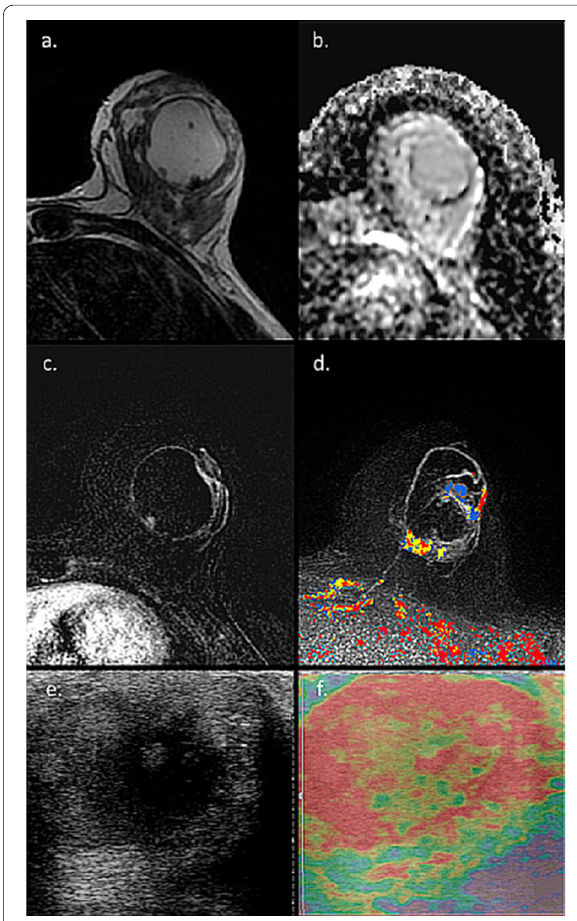
Fig. 7 MRI of duct ectasia. MRI and US images of 40‑year‑old lactating patient with palpable mass on the left breast are presented. Initial work‑up included US which revealed a 4 cm cystic mass with thick boundaries, with relative mixed cystic areas ( e ) and stiffness on static elastography ( f ). On MRI, T2‑weighted image reveals a high signal cystic structure ( a ), without internal restriction on ADC map ( b ), though with enhancement of its walls on DCE and CAD ( c , d ). Finally, US‑guided biopsy ruled out malignancy with duct ectasia